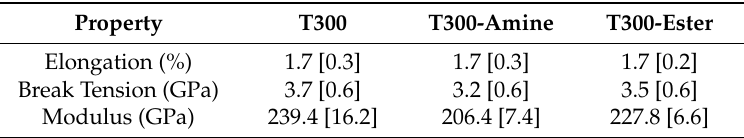
Table 1. Carbon fiber material properties table.